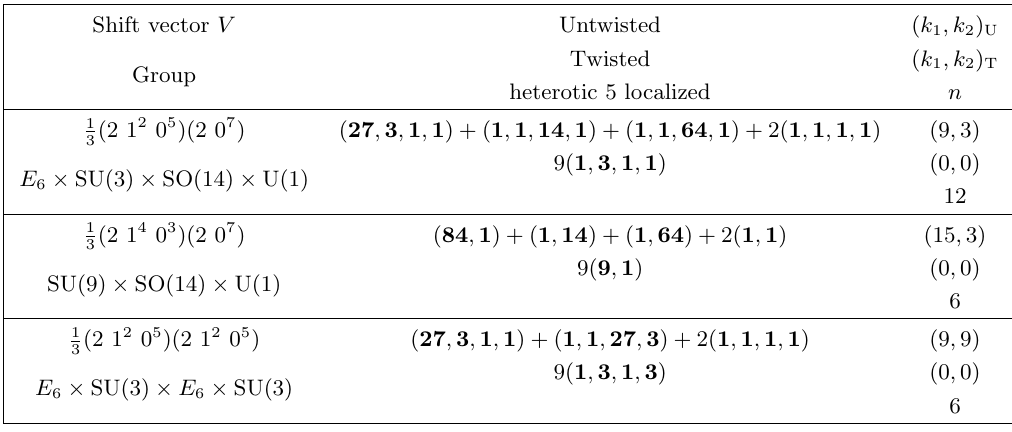
Table 5 . (Possibly) inconsistent vacua of E 8 (cid:2) E 8 heterotic string on T 4 = Z 3 orbifold, but passing the selection